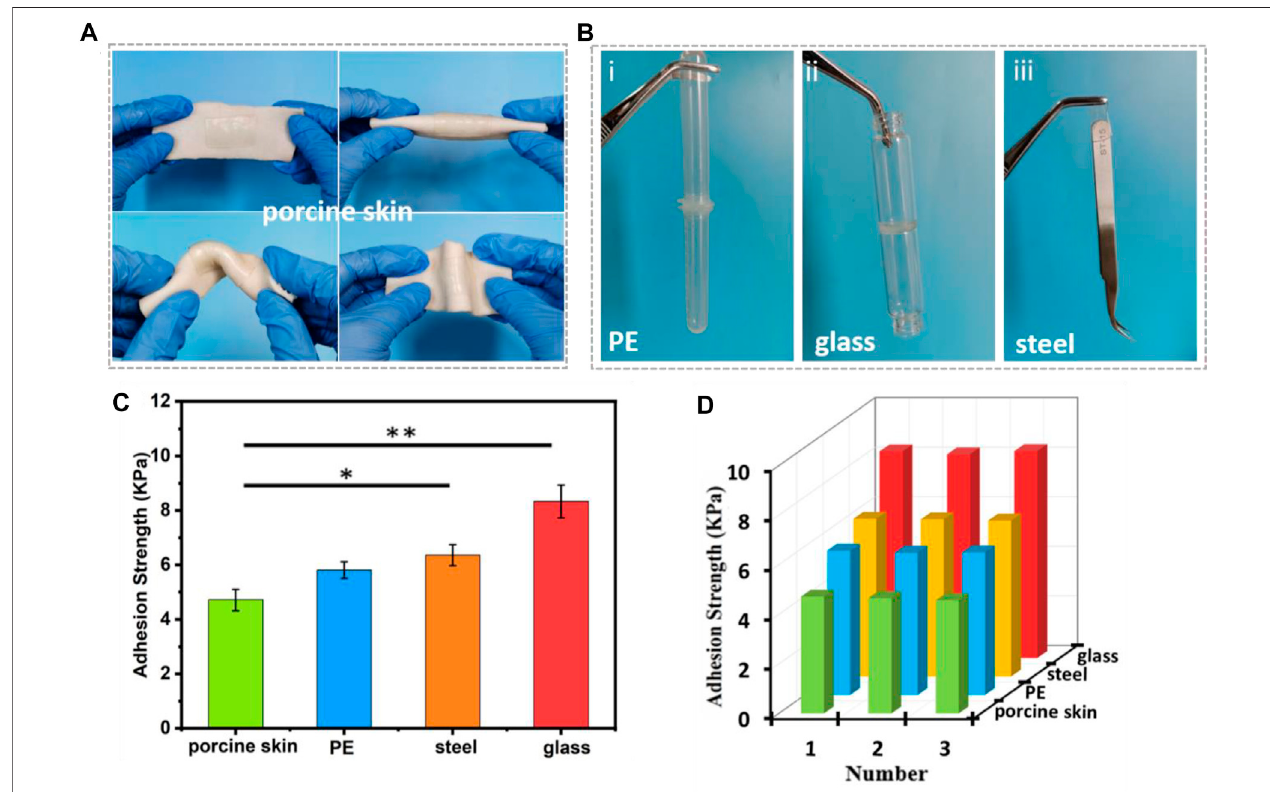
FIGURE 5 | Adhesion performance of the ADN 1.5 hydrogels. Photos of the self-adhesive hydrogels attached on porcine skin. (A) Photos of the self-adhesive hydrogels attached on porcine skin. (B) Photos of the self-adhesive hydrogels attached on PE (i), glass (ii), stainless steel (iii). (C) Adhesive strength of the ADN 1.5 hydrogels to different substrates. (D) Repeatable self-adhesive behavior of the hydrogels to different substrates. ** p < 0.01, * p <